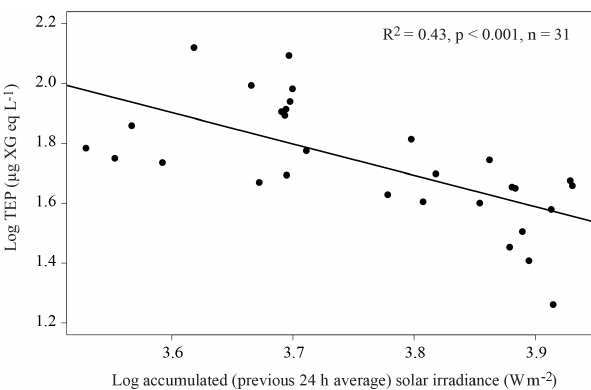
Figure 4. Relationship between the 24h-average (previous to sam- pling) solar irradiance (Wm − 2 ) and TEP (µgXGeqL − 1 ) in the OAO (CU sample excluded). The linear regression line is plotted and the equation